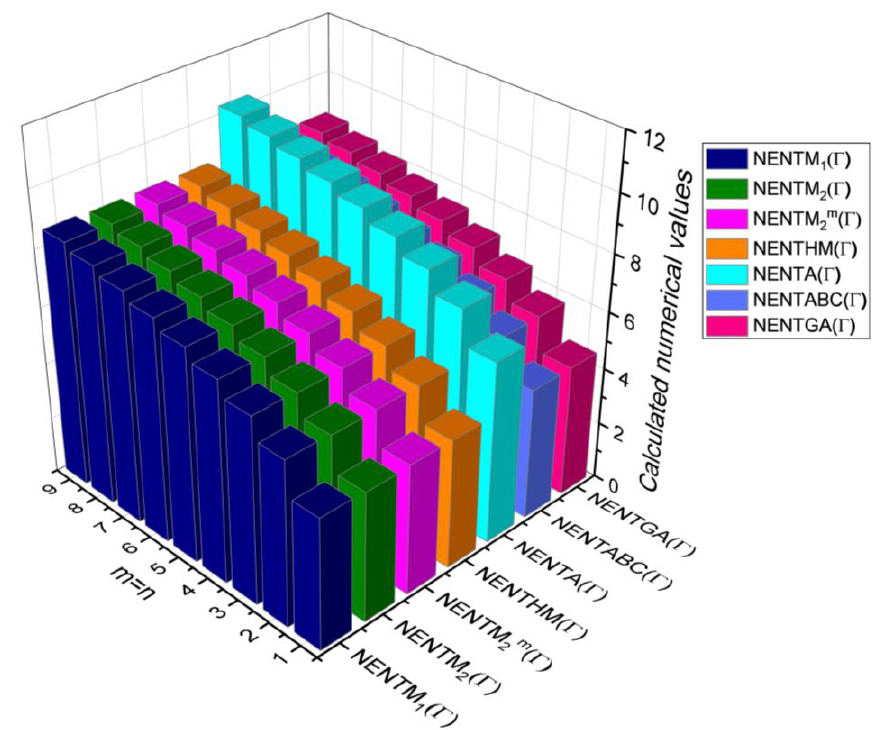
Figure 17. 3D plots for Table 15.